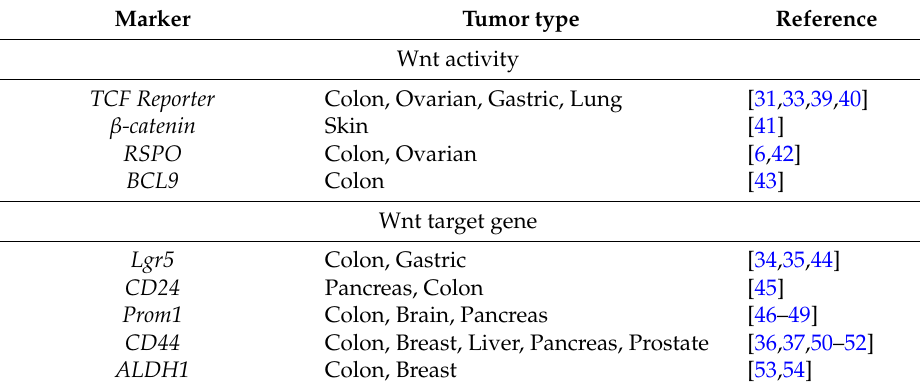
Table 1. Wnt activity defines cancer stem cells (CSCs) in multiple malignancies. Below is an overview of the relationship between Wnt signaling activity and CSC properties in various malignancies. Of note, this is by far not a complete overview but only intended to provide several key